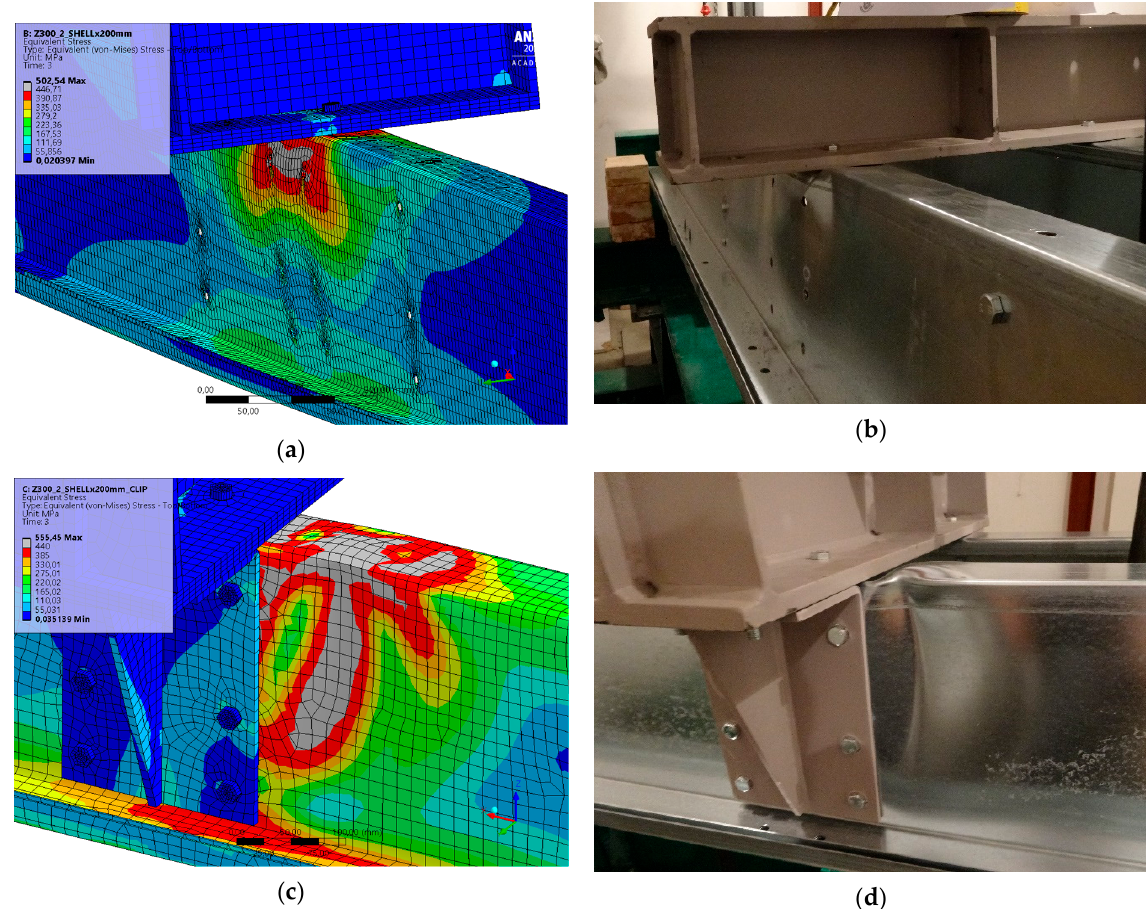
Figure 13. Detail of the purlins and failure mode after the experiment: von Misses stress without cleats ( a ), experiment without cleats ( b ), von Misses stress with cleats ( c ) and experiment with cleats ( d ).